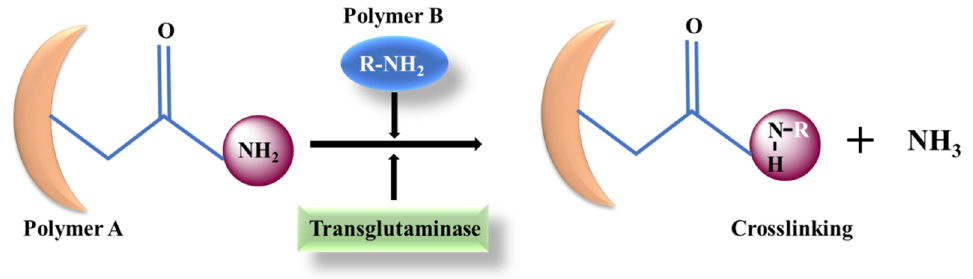
Figure 8. Mechanism of action of transglutaminase-mediated crosslinking strategy for hydrogel for- mation.